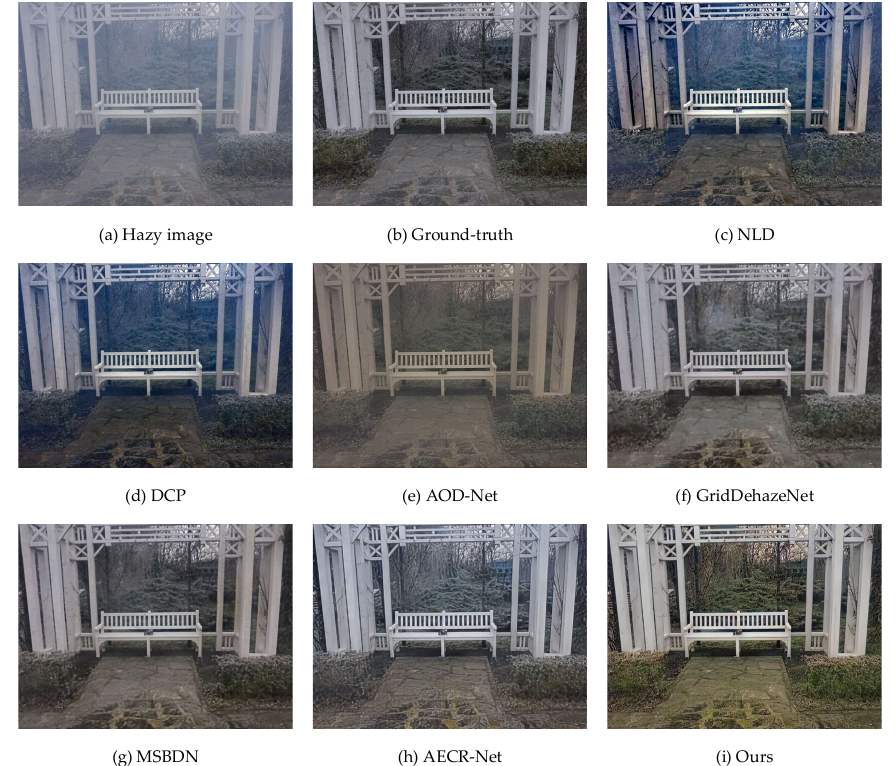
Figure 6. Visual quality comparison of O-HAZE dataset.